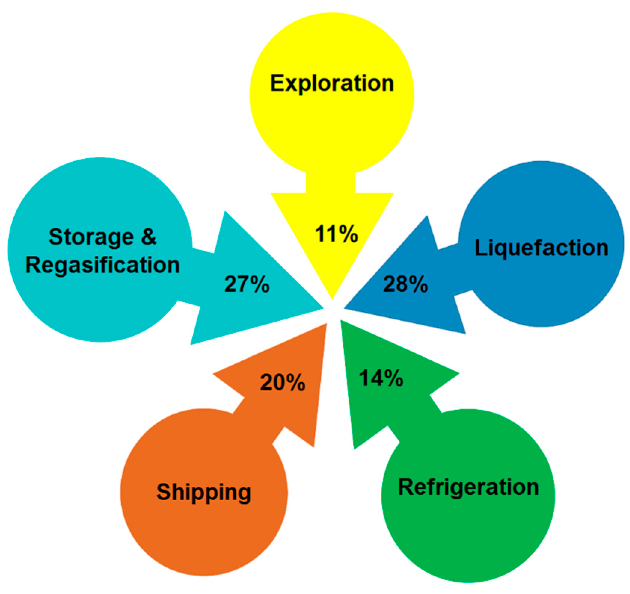
Figure 1. Breakdown of liquefied natural gas (LNG) project cost by relative expenditure [13].